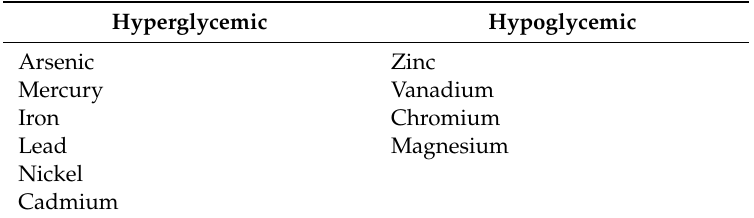
Table 1. Categorization of di ff erent elements as hyper- or hypoglycemic [13].